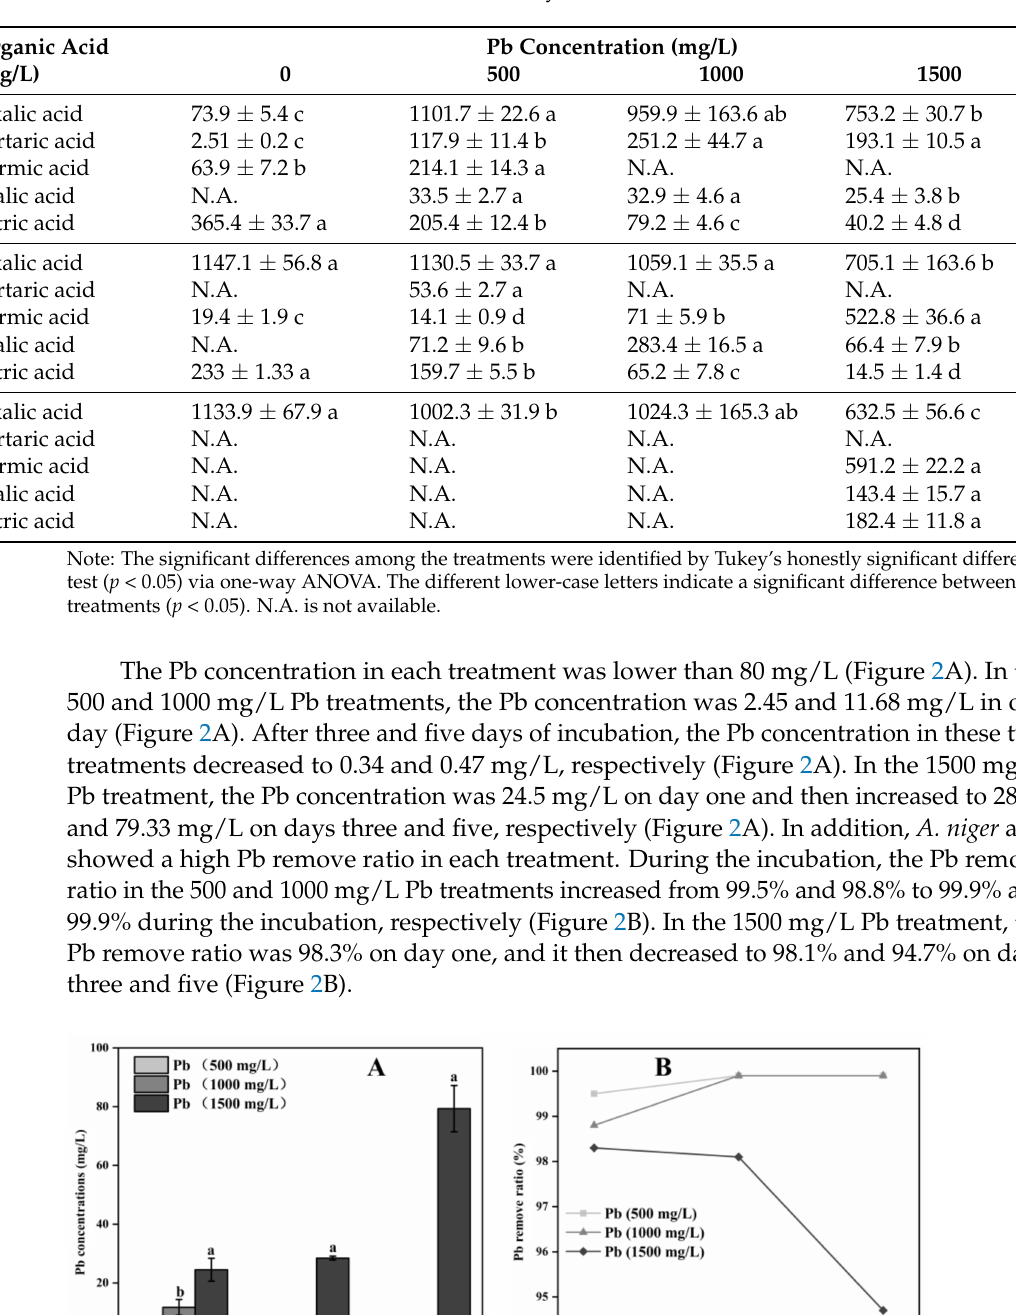
Table 1. The oxalic, tartaric, formic, malic, and citric acids produced by A. niger under different Pb levels after incubation for one, three, and five days.